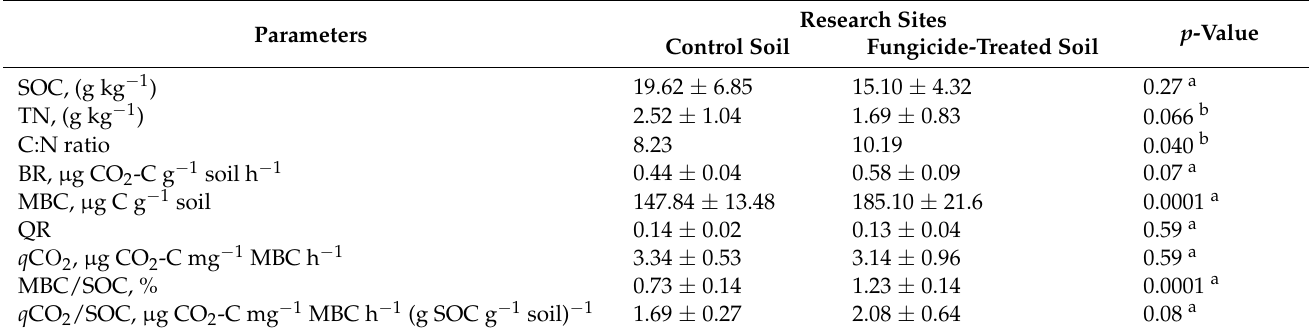
Table 1. Soil chemical and microbiological